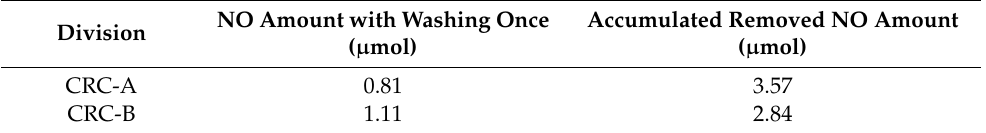
Table 6. NO removal results for CRC board panel